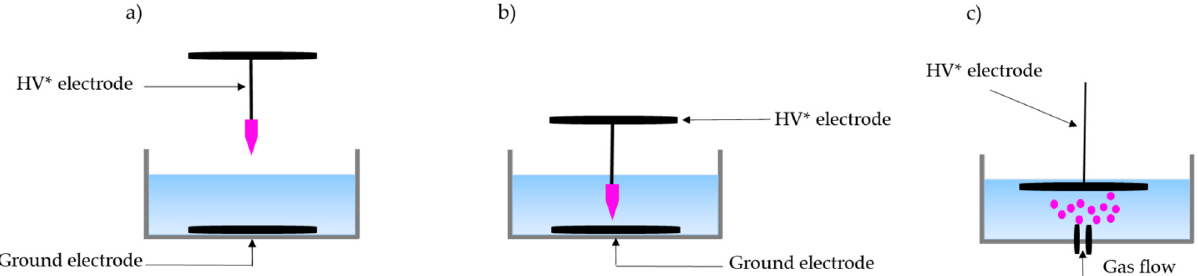
Figure 3. Schematic of different plasma discharge systems used for water treatment; ( a ) Discharge above liquid, ( b ) Discharge in liquid, and ( c ) Discharge in bubbles, * HV—high voltage. (adapted from [59]).